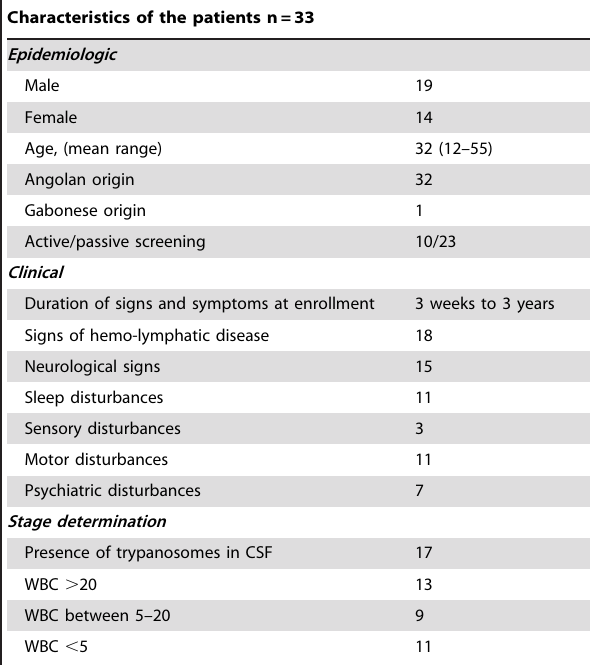
Table 1. Clinical and epidemiological features of the subjects